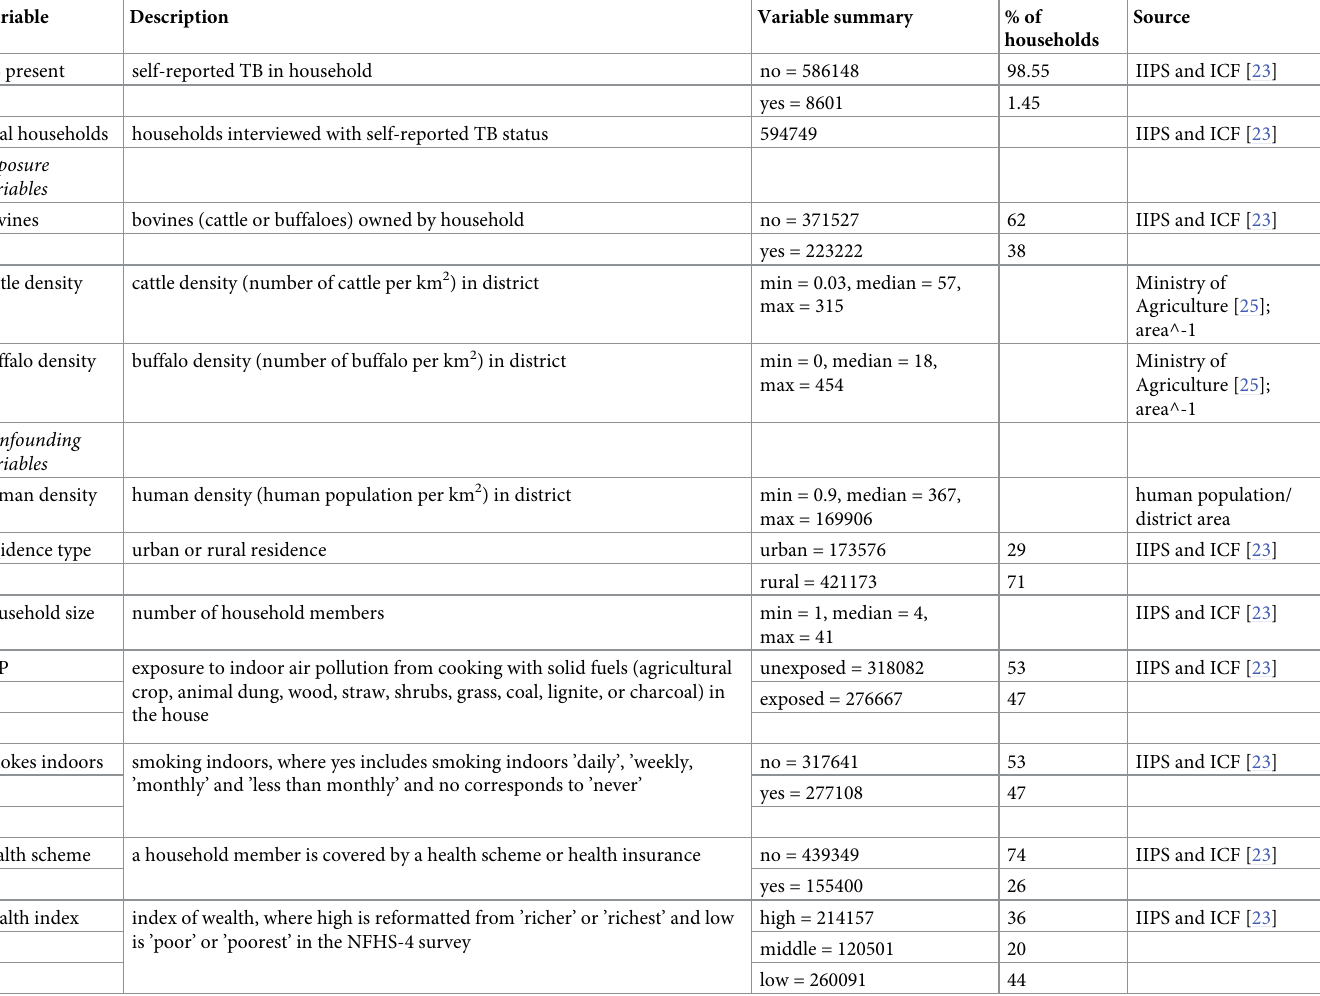
Table 1. Description and summary statistics of variables considered for the household level model of self-reported human tuberculosis in households in India. Data were sourced from a survey covering 601 509 households with ever-married women in India in 2015 [23].